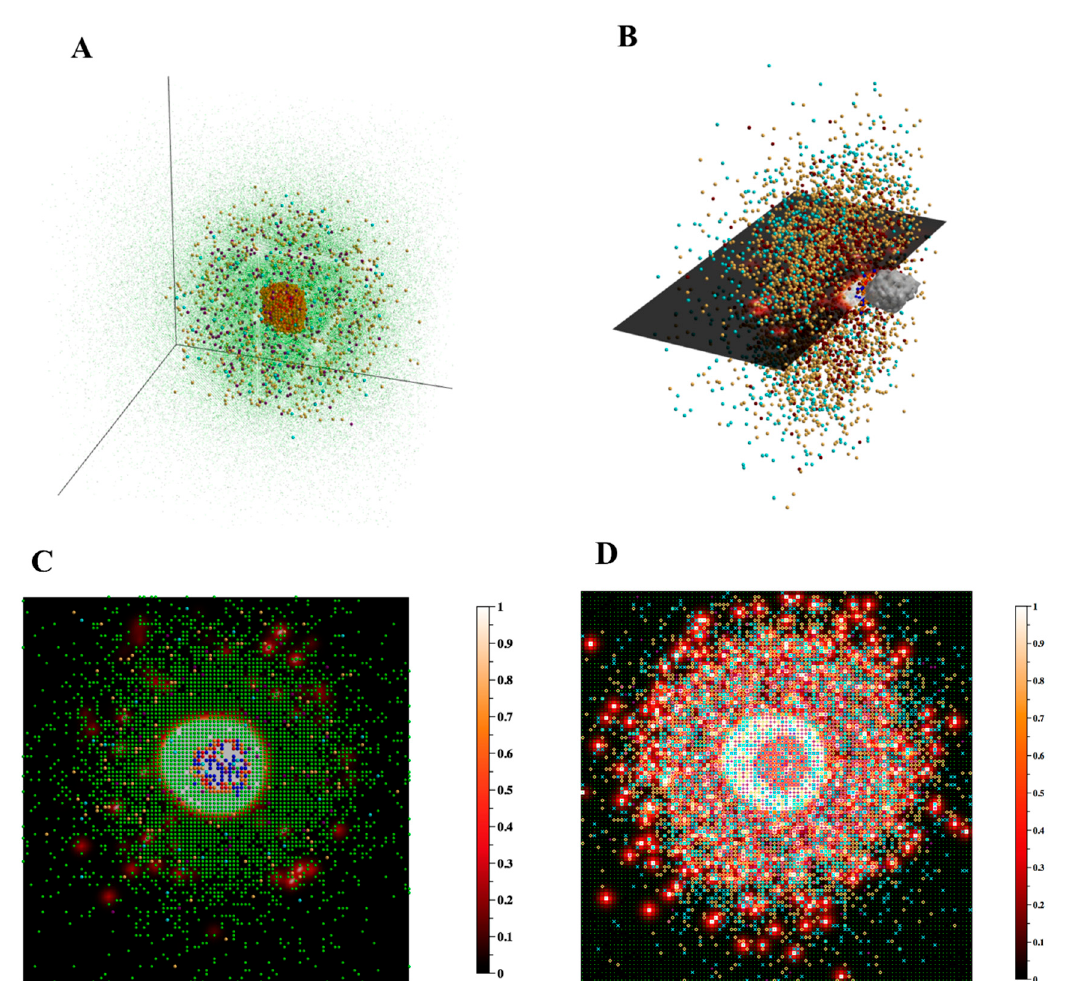
Figure 5. Visualizing the agents in 3D. ( A ) The 3D xyz-locations of the agents are shown at day 29 post infection. Macrophages (green—resting, orange—infected, red—chronically infected, blue—activated), T cells (yellow-orange—Tgam, maroon—Tcyt, cyan—Treg), extracellular Mtb (not shown), necrosis/caseum (not shown). For better visualization, resting macrophages are plotted at a smaller size than other cell types so as not to obscure other cells. Shown axes are xyz-positive. ( B ) To better visualize the interior of the granuloma, displayed agents from ( A ) are restricted to the sub-region [0,99] × [0,49] × [0,99] of the xyz-grid and resting macrophages are not shown. A 2D mesh xy-slice (also restricted to this sub-region) displays the current TNF gradient at z = 50. Grid compartments in which there has been at least one cell death contributing to caseum formation are enclosed by a light gray 3D surface. The display of this caseum ‘surface’ is not restricted to the above sub-region, and instead reflects the entire 100 × 100 × 100 grid. Data correspond to day 32 post infection. ( C ) The 2D xy-slice from ( B ), rotated as though viewed from above, and no longer restricted to the above sub-region, instead drawing from the entire 100 × 100 xy-grid. All agents with a z-value of 50 are shown, including resting macrophages. ( D ) In contrast to ( C ), in which we show a single z-slice of the 3D data, here we show an alternative way of visualizing 3D data in 2D space, a projection of the agents and TNF gradient onto the 2D xy-plane z = 0. Data correspond to day 32 post infection.